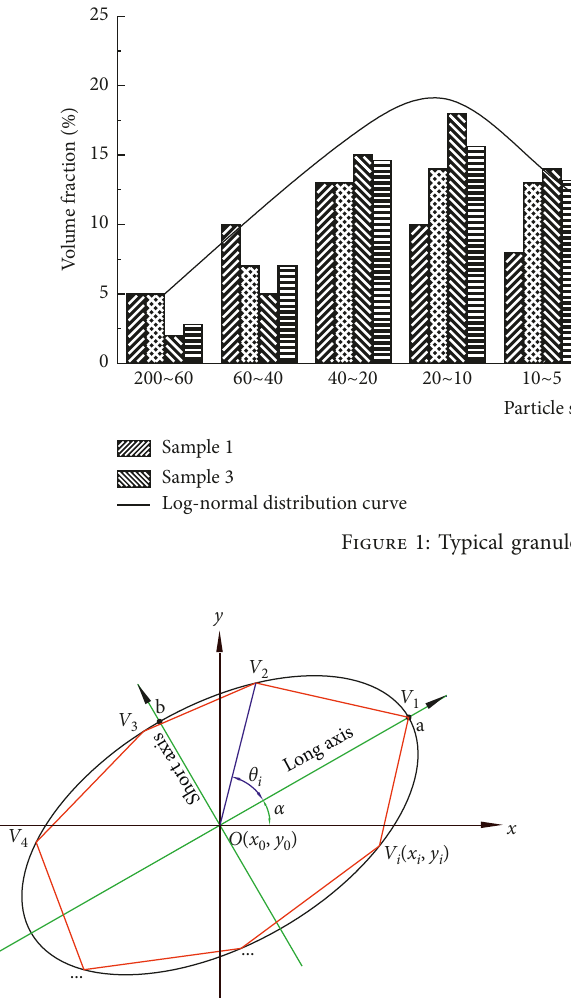
Figure 2: Random geometric shape of rock